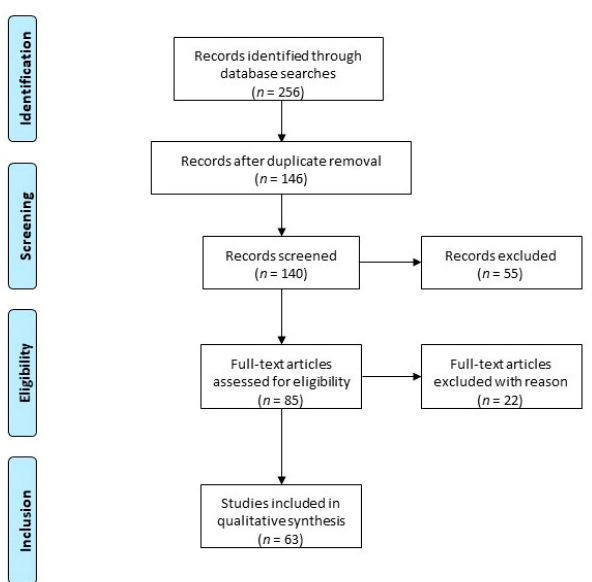
Figure 1. Article disposition flow diagram: The following keywords were used: uterine fibroids, progesterone, progestogen, GnRH agonist, GnRH antagonist, heavy menstrual bleeding, add-back therapy. Two hundred and fifty-six records were identified. After duplicate removal, 140 records were screened, of which only peer-reviewed articles focusing on the subject were considered for eligibility assessment ( n = 63). Among the conducted studies, specific various criteria led to the exclusion of 22 papers due to duplicated results.